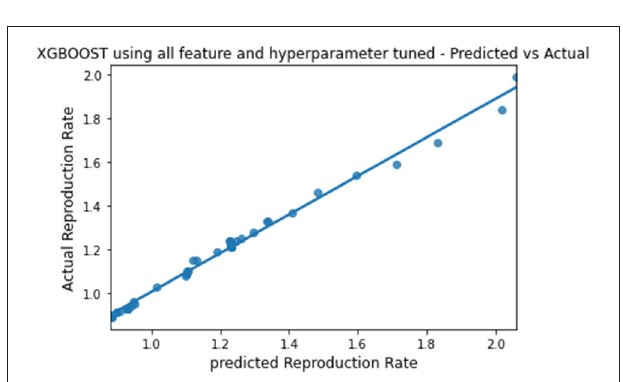
FIGURE 9 | Graph describing the predicted value vs. actual value of SVR.